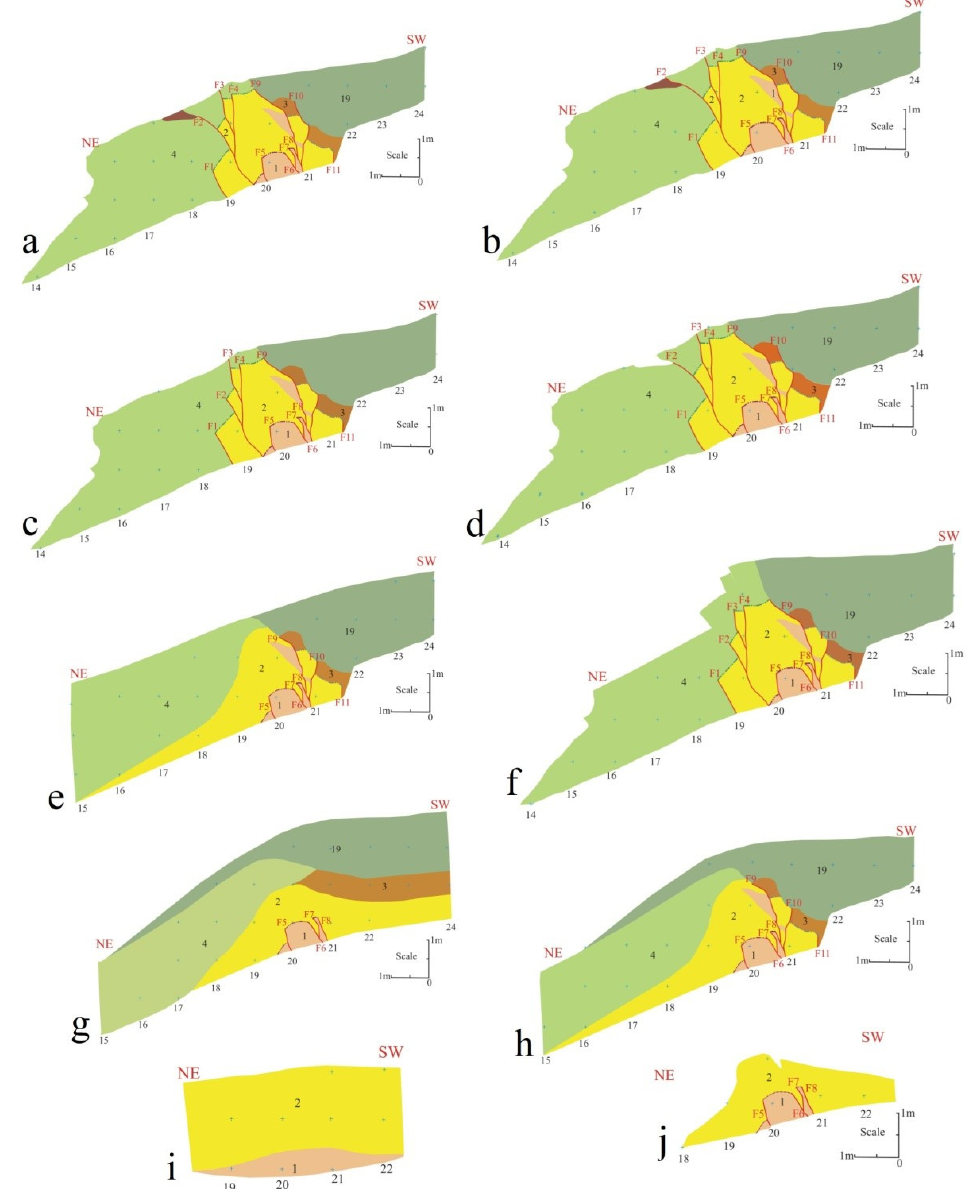
Figure 14. The back-stripping scenario on the eastern wall of the trench (TC). The scenario confirms the seismic deformation of the events Ev5 to Ev9 by Doroud Fault activity. The red lines are faults. ( a ) Pre-event 5. ( b ) Post-event 5 with faulting and fault scarp formation. ( c ) Pre-event 6. ( d ) Post-event 6 cutting unit C1 (colluviums wedge). ( e ) Pre-event 7. ( f ) Post-event 6 associated with cutting unit 4. ( g ) Pre-event 8. ( h ) Post-event 8 associated with cutting unit 3. ( i ) Pre-event 9. ( j ) Post-event 9 associated with cutting unit 2. Read the text for details.